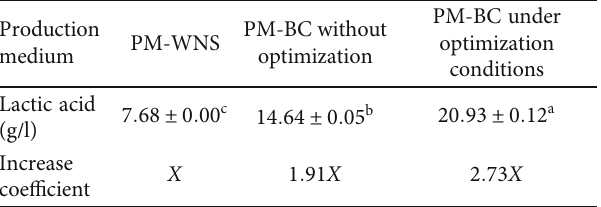
Table 9: Lactic acid production of Lactiplantibacillus plantarum strain 4O8 using BC and yeast